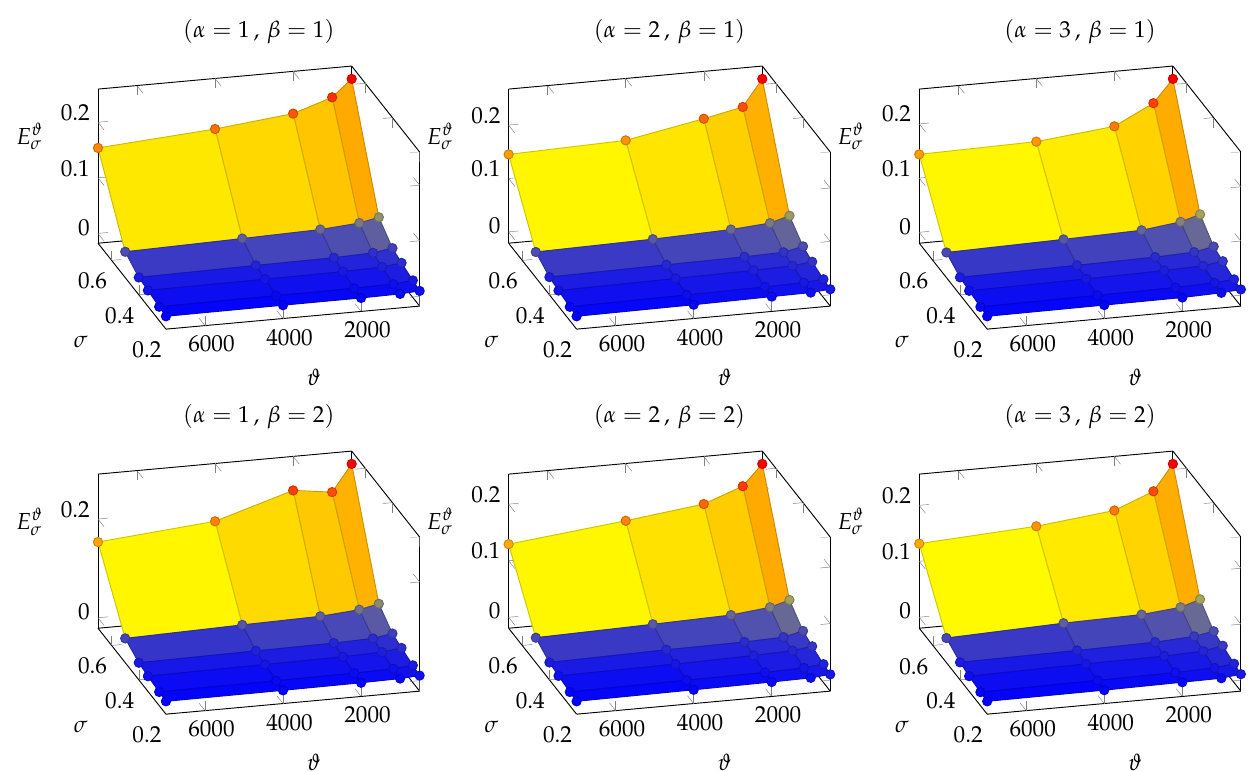
Figure 5. DFN158. Three-dimensional plot of the E ϑ σ values, varying ( σ , ϑ ) ∈ Σ × Θ , for each NN of architecture A α trained with configuration β , for each α = 1,2,3, and for each β =